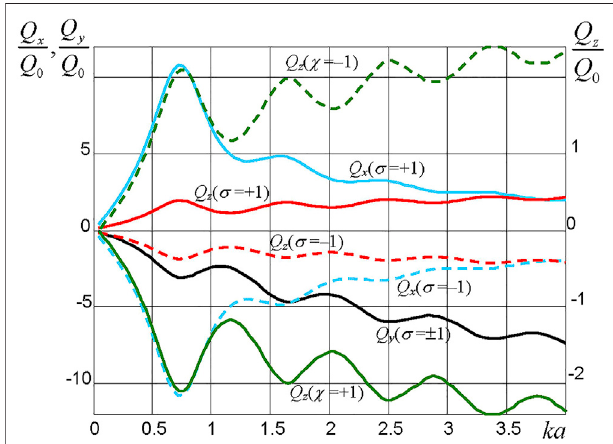
FIGURE 7 | Normalized radiation torque Q components vs the particle size parameter, ka , calculated for the gold particle situated on the surface of the glassprism ( n 1 (cid:1) 1.75) inwaterat λ (cid:1) 650 nm when theincident wavewith λ (cid:1) 650 nm approaches the surface at an angle θ (cid:1) 51 ° : longitudinal 1 x -component, circular polarization (cyan curves, left scale); transverse y -component, circular polarization (black curve, left scale); vertical z -torque, circular polarization (red curves, right scale); vertical z -torque, 45 ° -polarization (green curves, right scale).